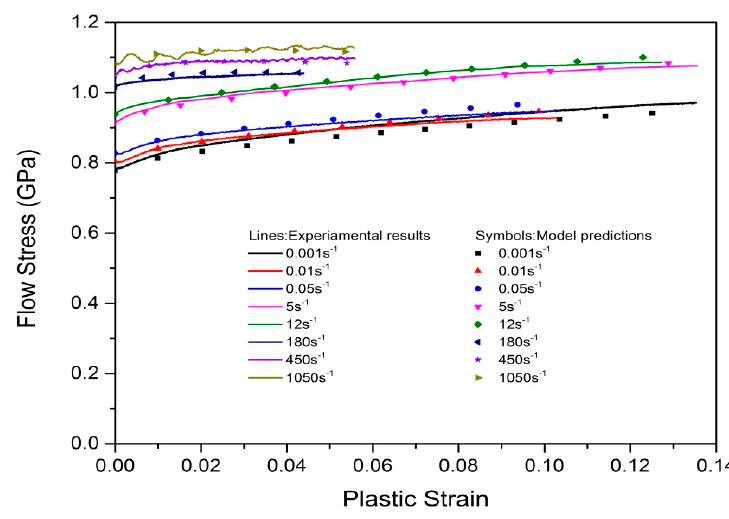
Figure 7. Comparison of the experimental results and model predictions.